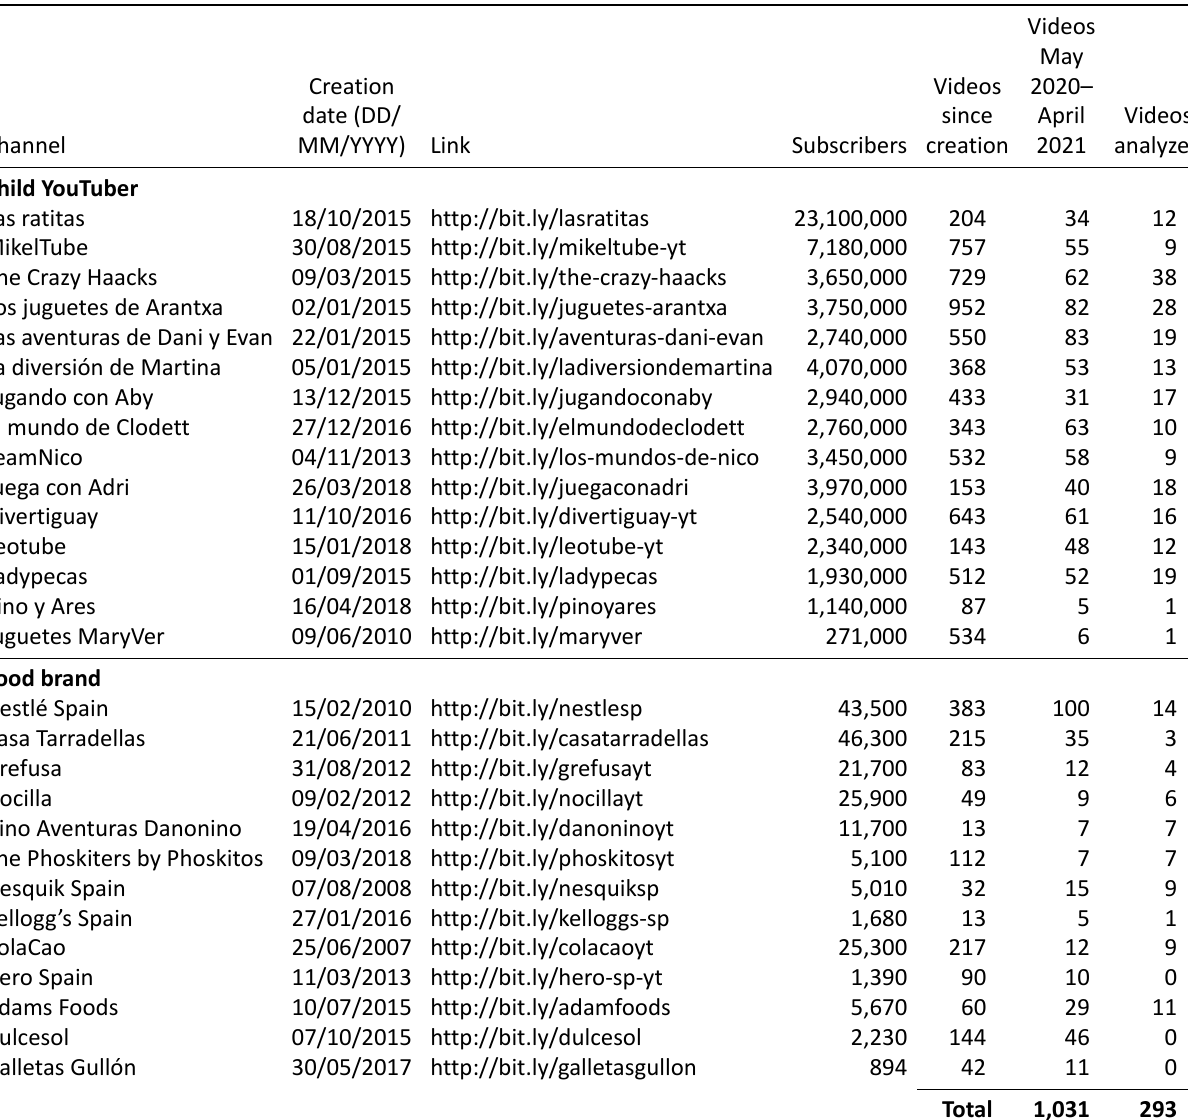
Table 1. Sample of YouTube